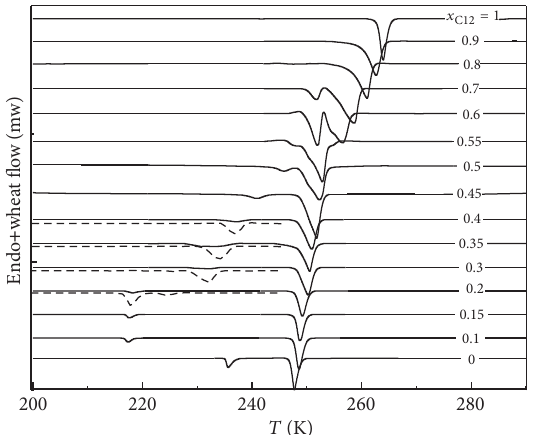
F 3: Experimental solid-liquid phase diagram of bulk C system. T represents triclinic crystal, R rotator